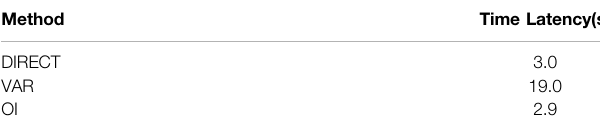
TABLE 5 | Time latency comparison of different wind retrieval